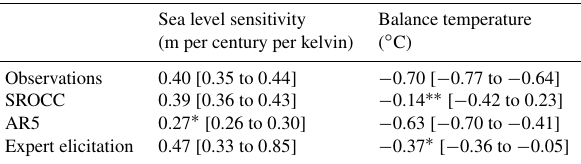
Table 1. Transient sea level sensitivity and balance temperatures estimated from different sources. Intervals are likely ranges (17%– 83%). Symbols indicate that the difference from the observational estimate is significant at ∗ p< 0 . 05 and ∗∗ p< 0 . 1 using a two-tailed test assuming